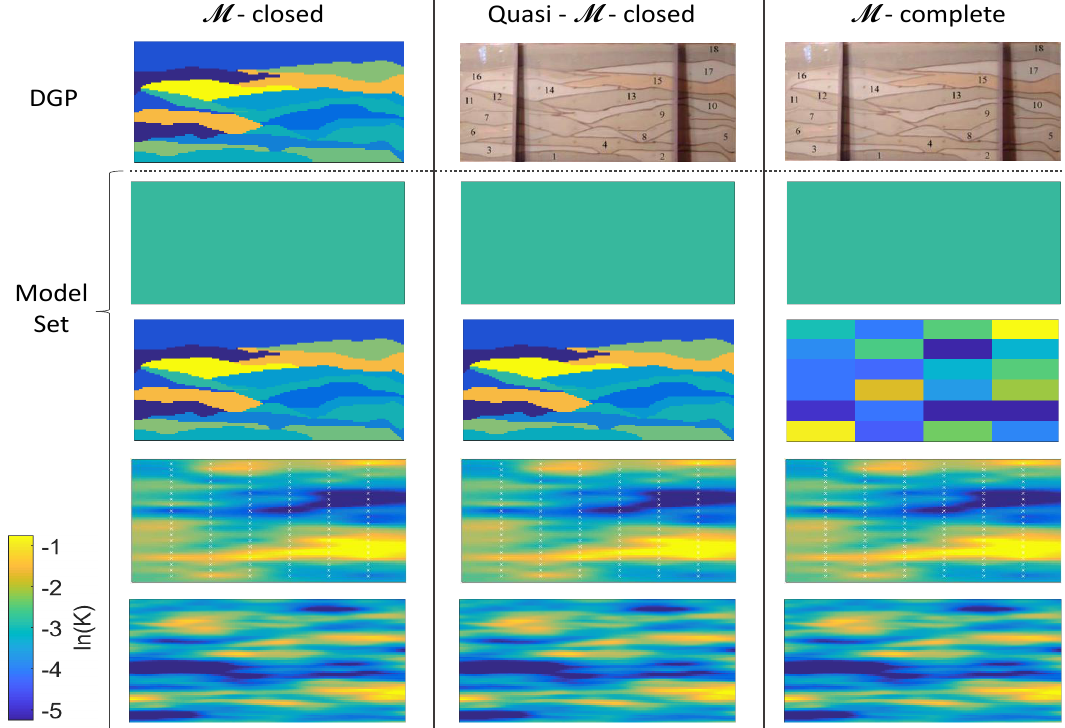
Figure 3. Defined M -settings for the applied modelling example: 1st column) M -closed—DGP: informed zonated model—model set: homogeneous, inf. zonated, pilot-point and geostatistical; 2nd column) Quasi- M -closed—DGP: sandbox—model set: homogeneous, inf. zonated, pilot-point